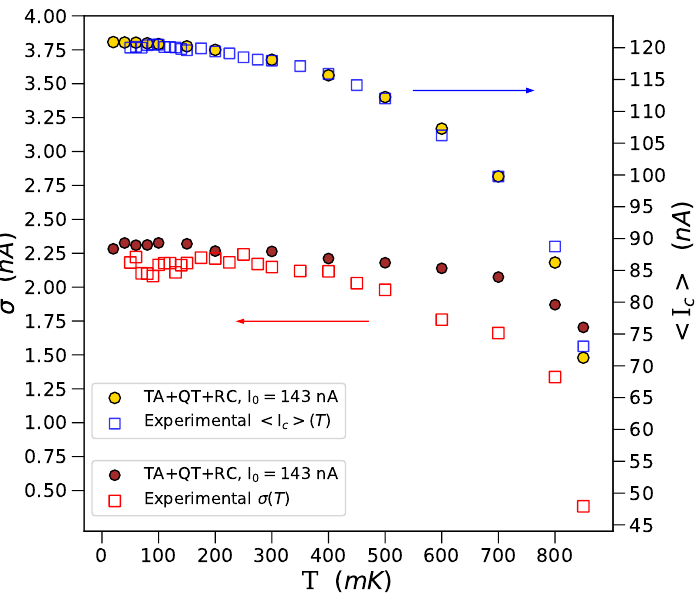
Figure 10. Comparison of the mean switching currents and widths of the simulated data with R p = 1 k Ω , C = 2 pF, R J = 100 k Ω , I 0 = 143 nA, and C J = 0.2 pF with respect to experimental results of the 2 µ m 2 µ m junction, shown in empty ×